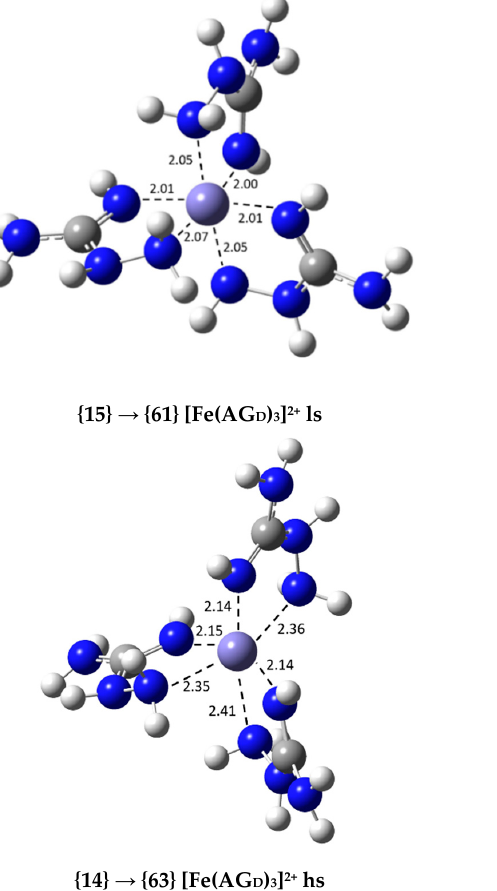
Figure 4. Optimized geometries of some of the Fe(II) complexes with AG in aqueous solution (indicating the Fe(III) complex used as the starting point in each case; bond distances in Å); high- (hs) and low-spin (ls) complexes are identified.